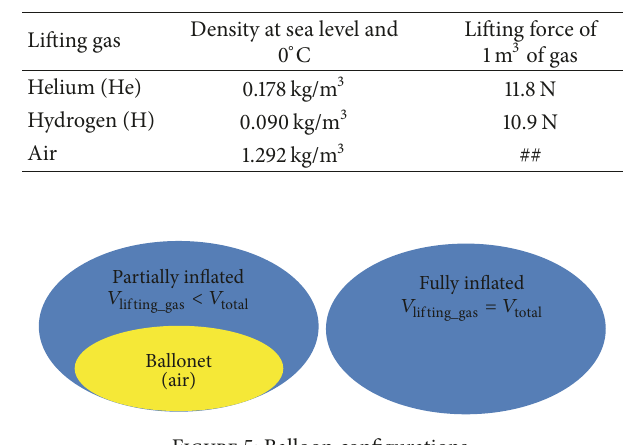
Table 5: Lifting gas comparison.